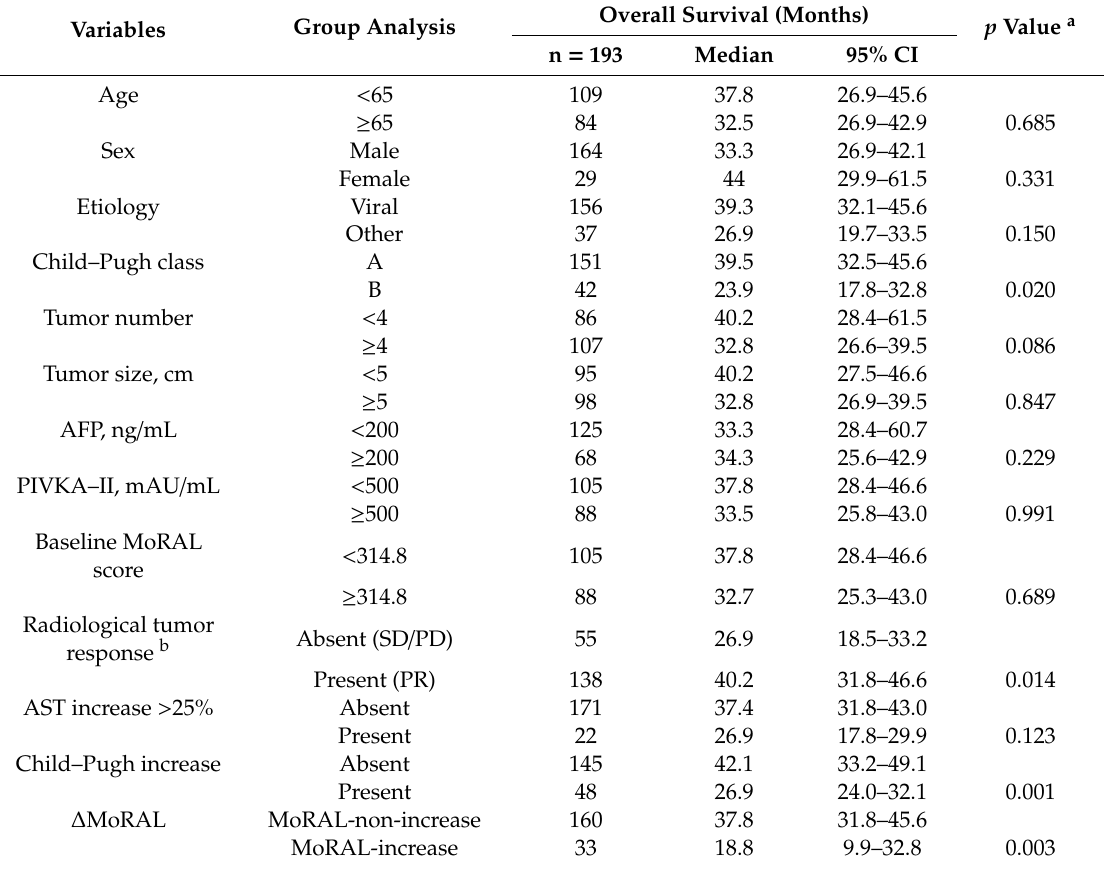
Table 2. Univariable analysis of prognostic factors in the training cohort (n =